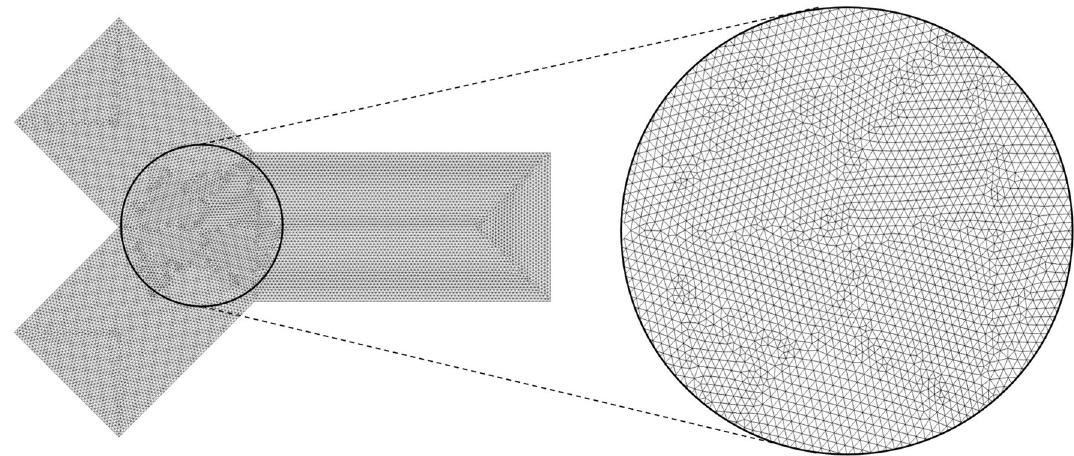
Fig. 2 Model’s mesh construction which includes 21,514 triangle